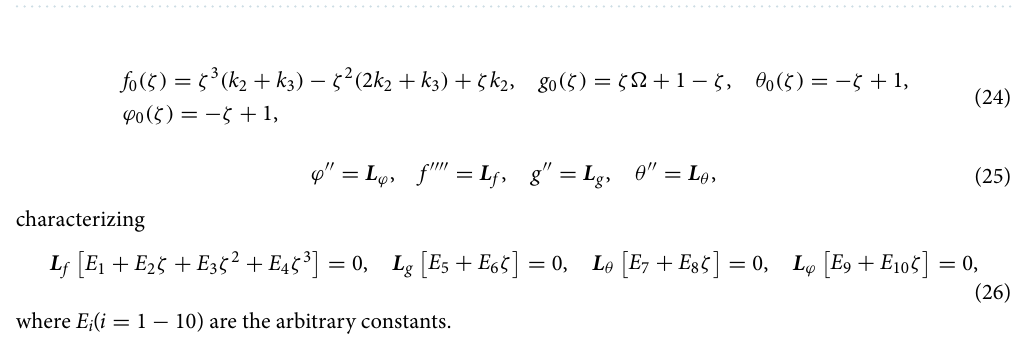
Figure 2. Analysis through Hall parameter m and radial velocity f ′ ( ζ